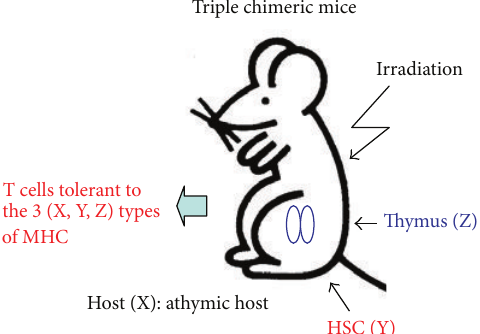
Figure 2: Use of third-party thymus tissue in triple chimera. Lethally irradiated athymic nu/nu mice (host: X) were transplanted with allogenic HSC (donor: Y) and third-party thymus (donor: Z) as triple